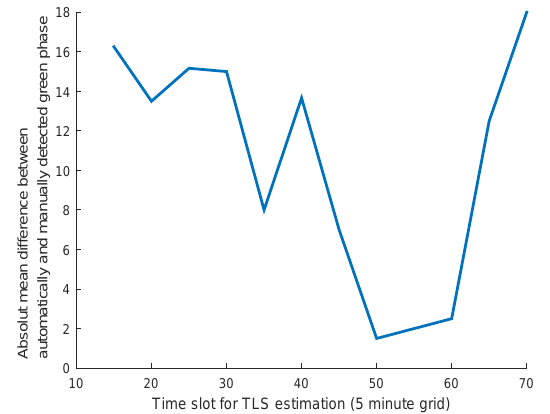
Figure 11: Mean difference between automatically and manually detected mean TLS for different time windows for the automatic detection